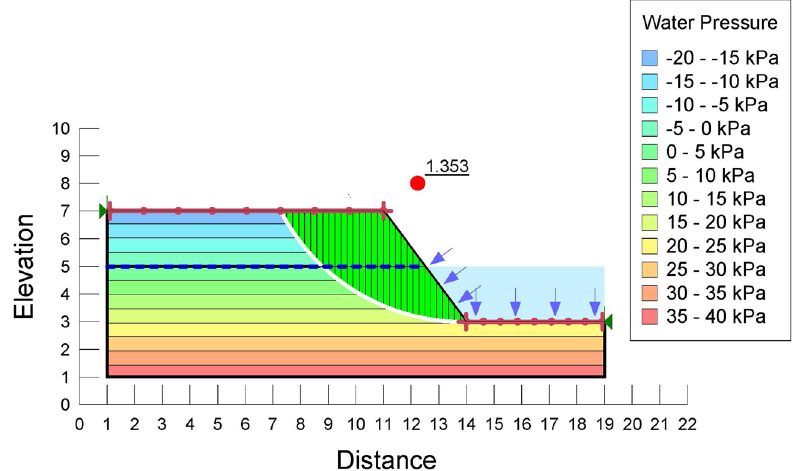
Figure 8: Slope stability after applying rationing